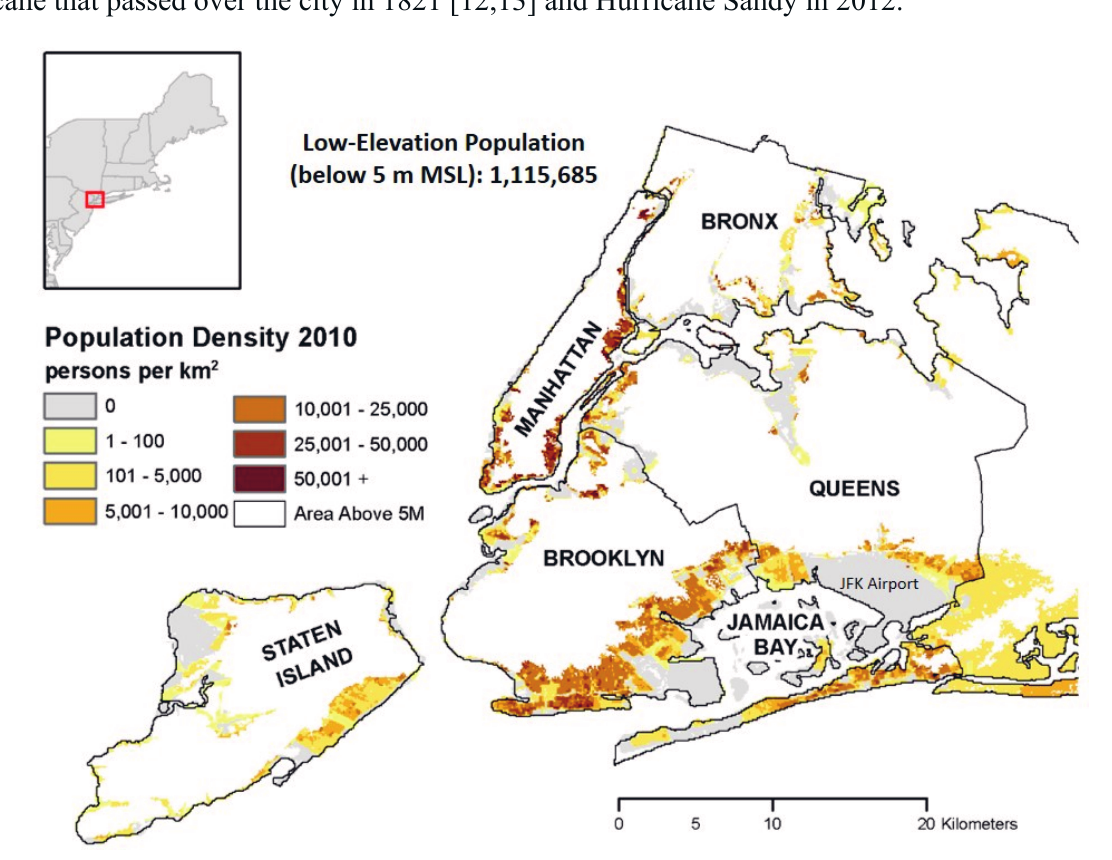
Figure 1. New York City boroughs and the western edge of Nassau County (right edge of map) showing the population density in contiguous low-elevation coastal zones below 5 m above mean sea level (MSL). The population density data are based on 100 m resolution 2010 population data [14]. LIDAR elevation data at 1 m resolution are used to filter for elevation; the map only shows population density data where >50% of a cell area is below 5 m elevation. Data available at